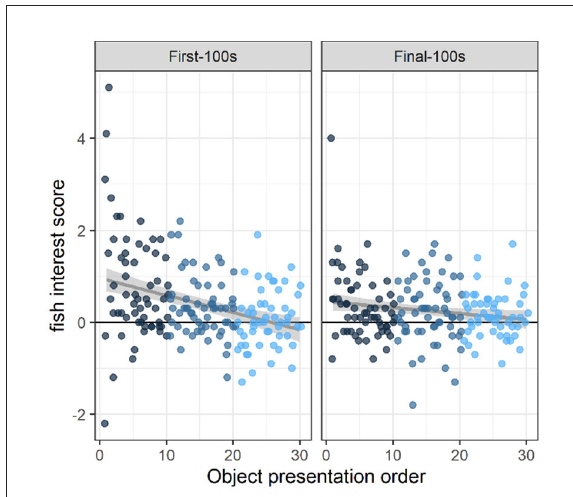
FIGURE2 Interest across novel object presentations. Fish interest scores were calculated as the difference in the average number of fish in the inner area (within two body-lengths of the object) during the object presentation period vs. a baseline period when there was no object present. These data show that fish were significantly attracted to the novel object at the beginning of the study (i.e., the first 10 objects they saw) during the first-100s of an object presentation ( p < 0.0001) and during the final-100s of object presentation ( p < 0.01). By the end of the study, (i.e., the last 10 objects they saw), there was no strong evidence of overall attraction to (or avoidance of) the novel object area ( p’s > 0.05). Across presentations, therefore, interest in the novel objects decreased during both periods (first-100s: p < 0.0001; and final-100s: p < 0.02). Dots indicate the number of fish in the object area above the average number of fish in the object area during baseline. Dots are colored according to object presentation order (dark blue: 1–10; medium blue: 11–20; light blue: 21–30) and are jittered slightly (random noise added to avoid overlapping). Gray lines and shaded areas represent the best linear fit and its 95% Confidence Interval.